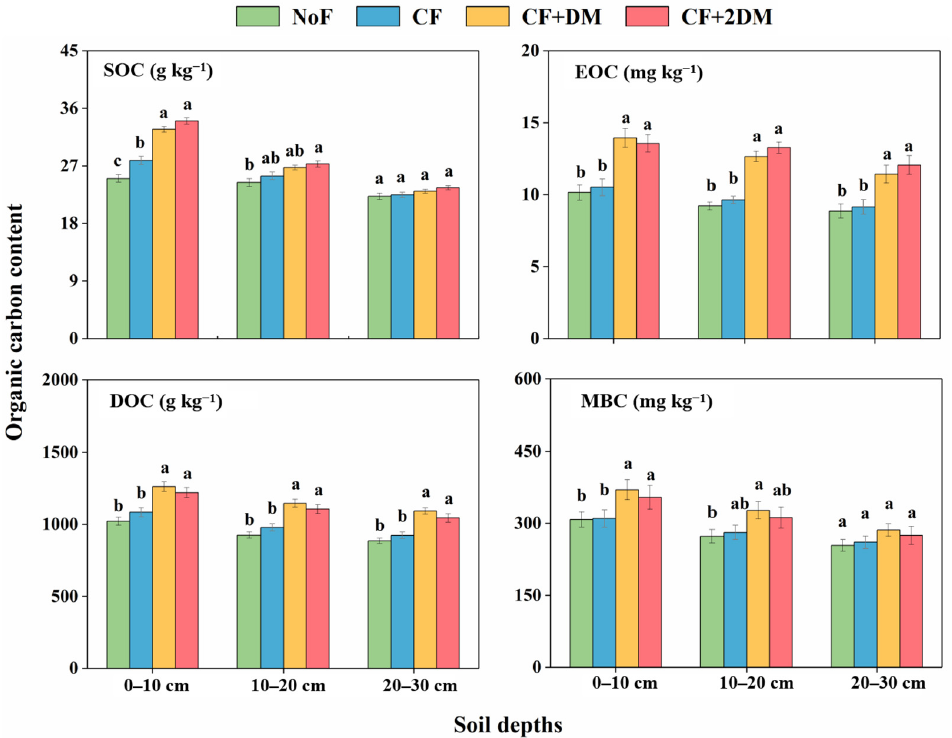
Figure 2. The contents of soil organic carbon and organic carbon fraction in bulk Mollisols under different fertilization treatments. In the same soil layer, the various letters of the same fraction exhibited significant differences at the p < 0.05 level via Tukey’s HSD test under the four treatments. NoF, non ‐ fertilizer. CF, only chemical fertilizer. CF + DM, chemical fertilizer plus with single dairy manure. CF + 2DM, chemical fertilizer plus with double dairy manure. The specific meanings of organic carbon fractions with abbreviations are presented in Table 1.